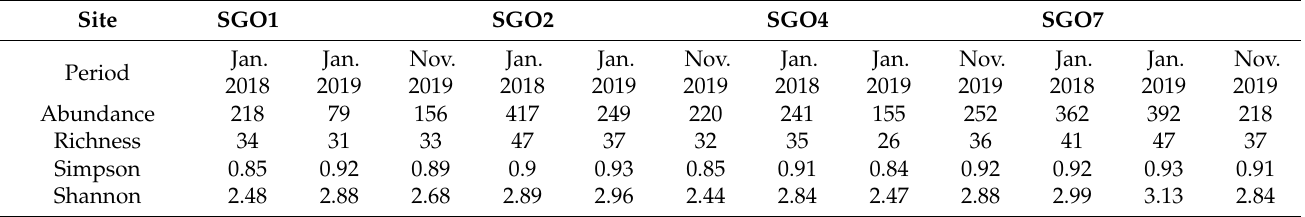
Table 2. Total abundance, total species richness, Simpson and Shannon indexes for each site at SGO at each period (Data for the other sites are available in Feer & Boisier